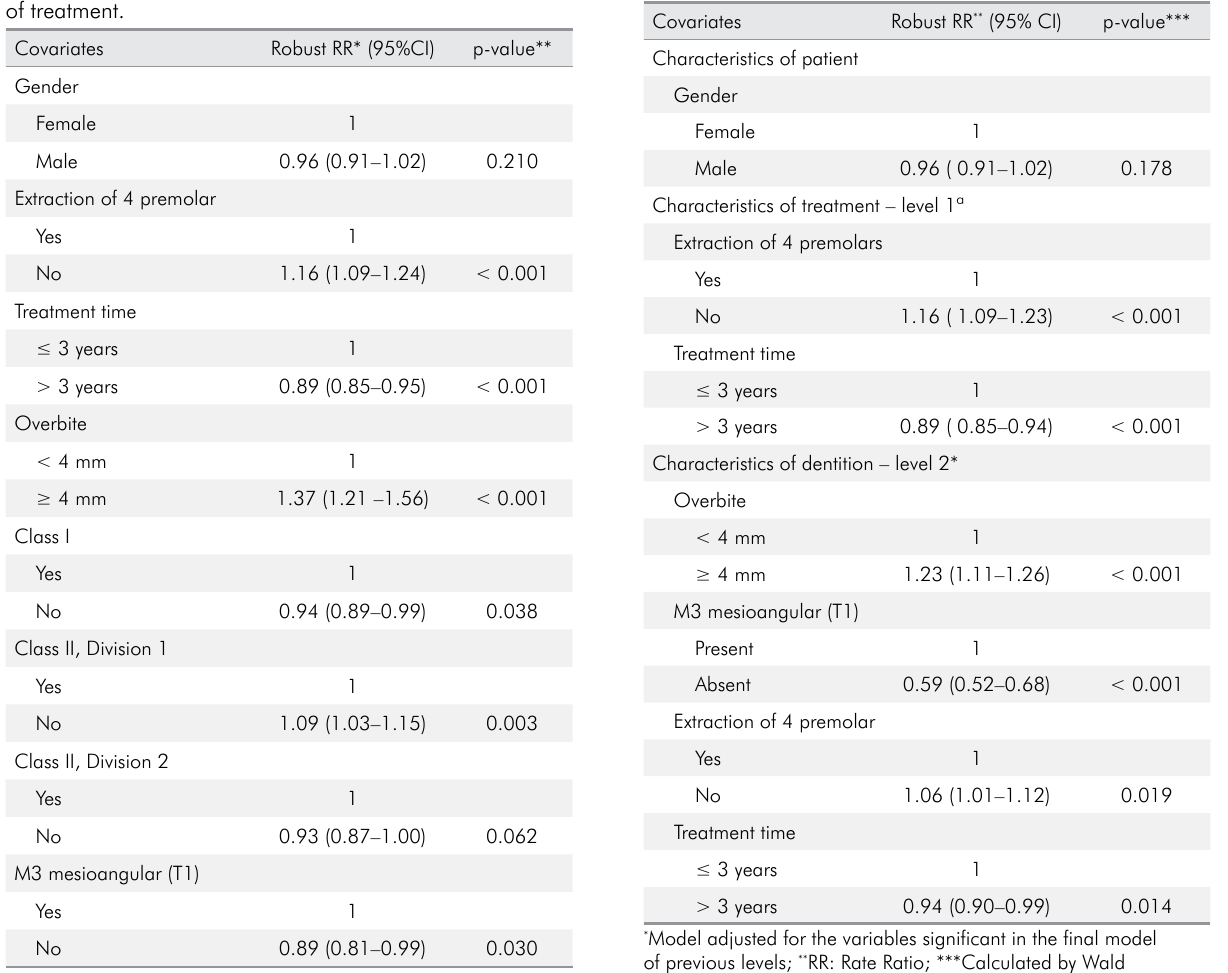
Table 3. Final poisson regression model for covariates associated with impacted third